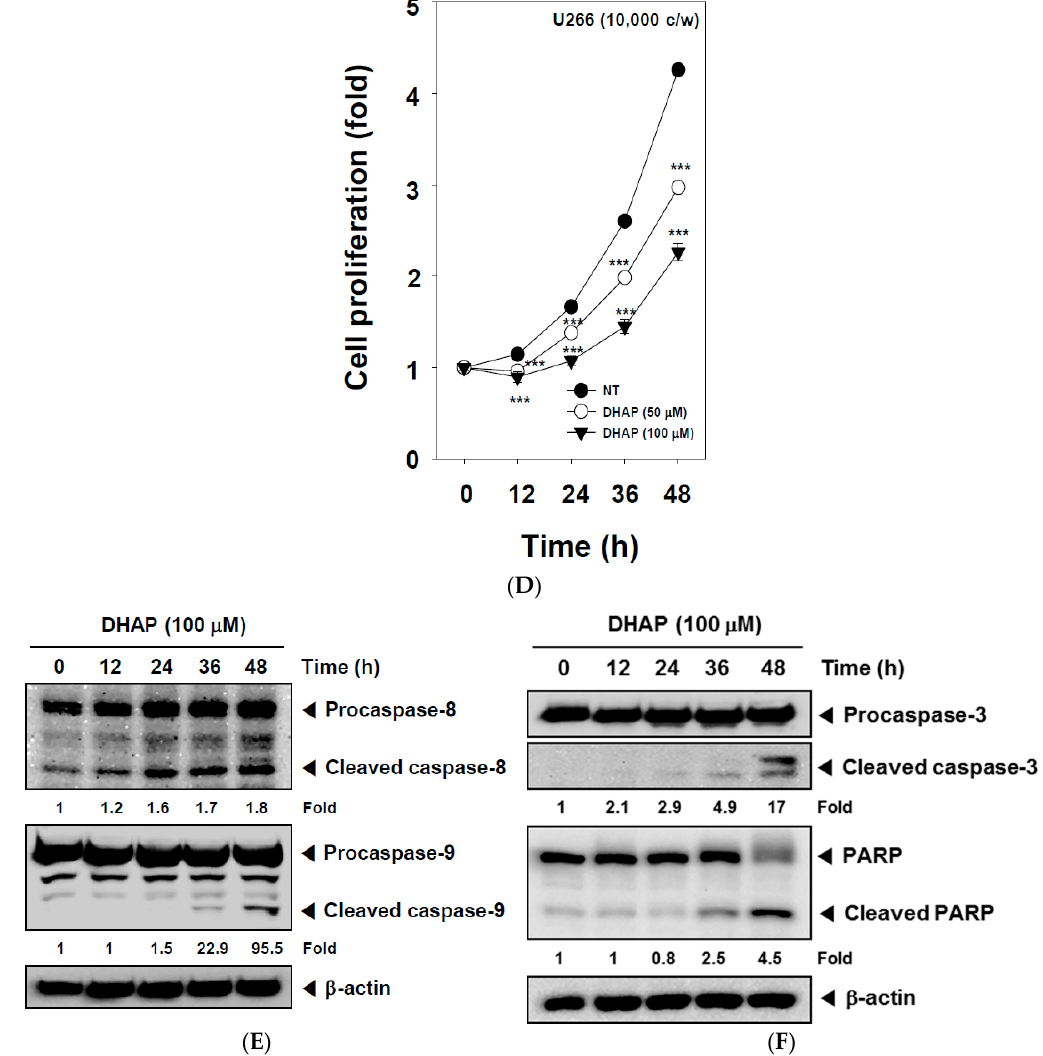
Figure 2. Effect of DHAP on apoptosis and proliferation of U266 cells. The cells were treated with 100 μ M of DHAP for 24 h and 48 h. ( A ) Cellular DNA staining incorporating PI and flow cytometric analysis was performed to ascertain the cell cycle distribution; ( B ) The cells were incubated with an FITC-conjugated Annexin V, then examined for an early apoptotic effect with flow cytometry; ( C ) The cells were fixed and incubated with a TUNEL reaction solution, then examined for DNA fragmentation with flow cytometry; ( D ) U266 cells were treated with 50 and 100 μ M of DHAP, then subjected to an